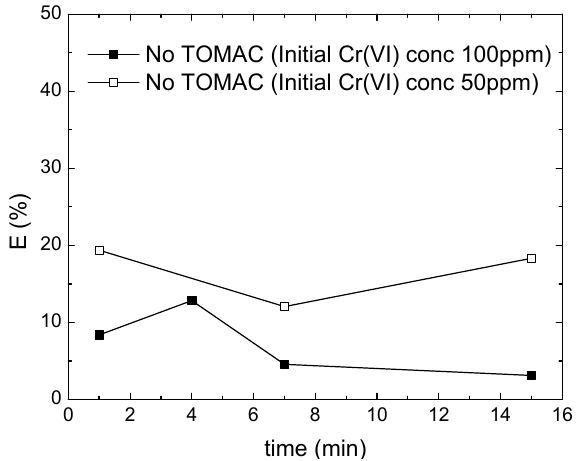
Figure 7. Chromium removal efficiency without TOMAC as carrier. Filled square ( ■ ) contains 3 wt% Span 80, 1 wt% Tween 80, 1 wt% butanol and 0.35 wt% TOMAC. Open square ( □ ) contains 2.5 wt% Span 80, 1 wt% Tween 80, 0.35 wt%